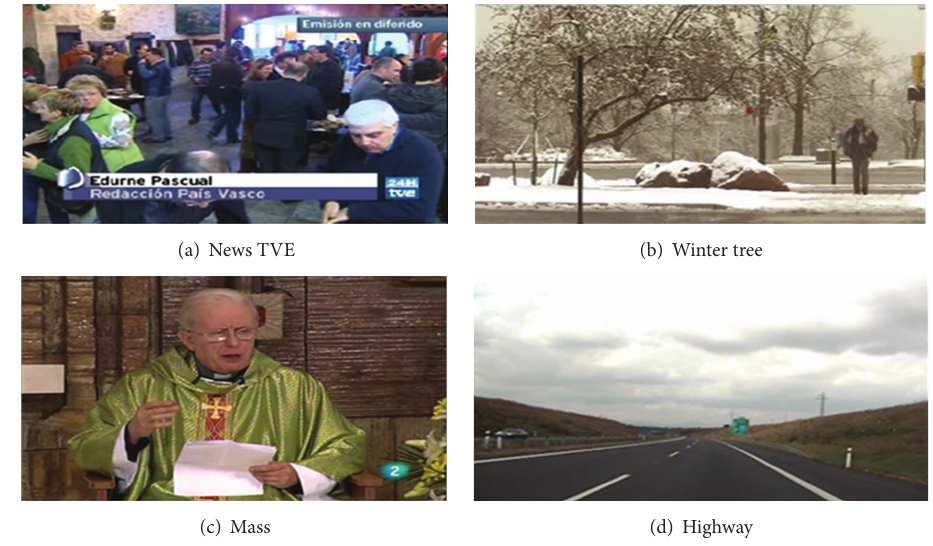
Figure 2: Screenshots from video sequences